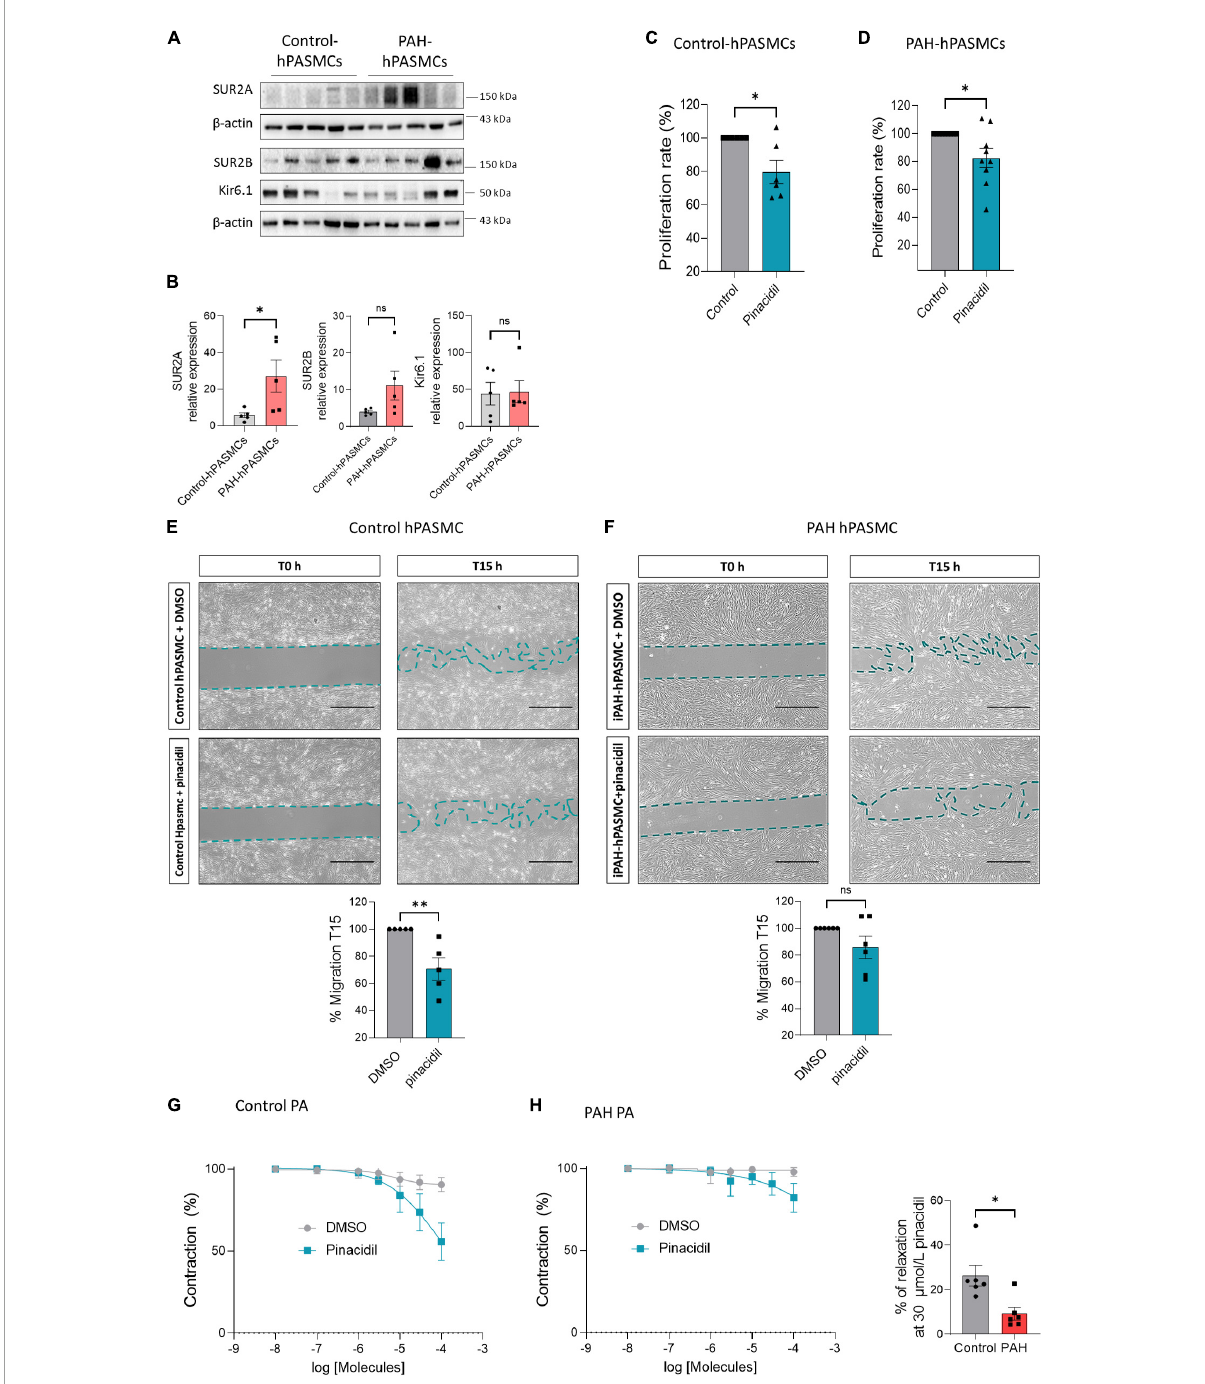
FIGURE3 Pharmacological activation of SUR2/Kir6.1 channel reduced the proliferation and migration of control and PAH-hPASMCs. (A) Representative western blots (A) and quantification (B) of SUR2A, SUR2B, and Kir6.1 in hPASMCs from controls and patients with PAH ( n = 5). Analysis by BrdU assay of the proliferation rate of hPASMCs from controls patients (C) and patients with PAH (D) treated with pinacidil (10 µ mol/L) or DMSO ( n = 6–7 patients). (E,F) Analysis of the migratory capacity of hPASMCs from controls (E) and patients with PAH (F) treated with pinacidil (10 µ mol/L) or DMSO ( n = 5–6 patients). Scale Bar = 500 µ m. (G) Dose-response to pinacidil (100 nmol/L to 100 µ mol/L) and DMSO on pre-contracted human PA control and iPAH (H) by 1 µ mol/L of U46619. Graphics represent the relaxation percentage at 30 µ mol/L of PA treated with pinacidil or DMSO ( n = 6 patients). ns: non-significant. ∗ p < 0.0 5 ∗∗ p < 0.001